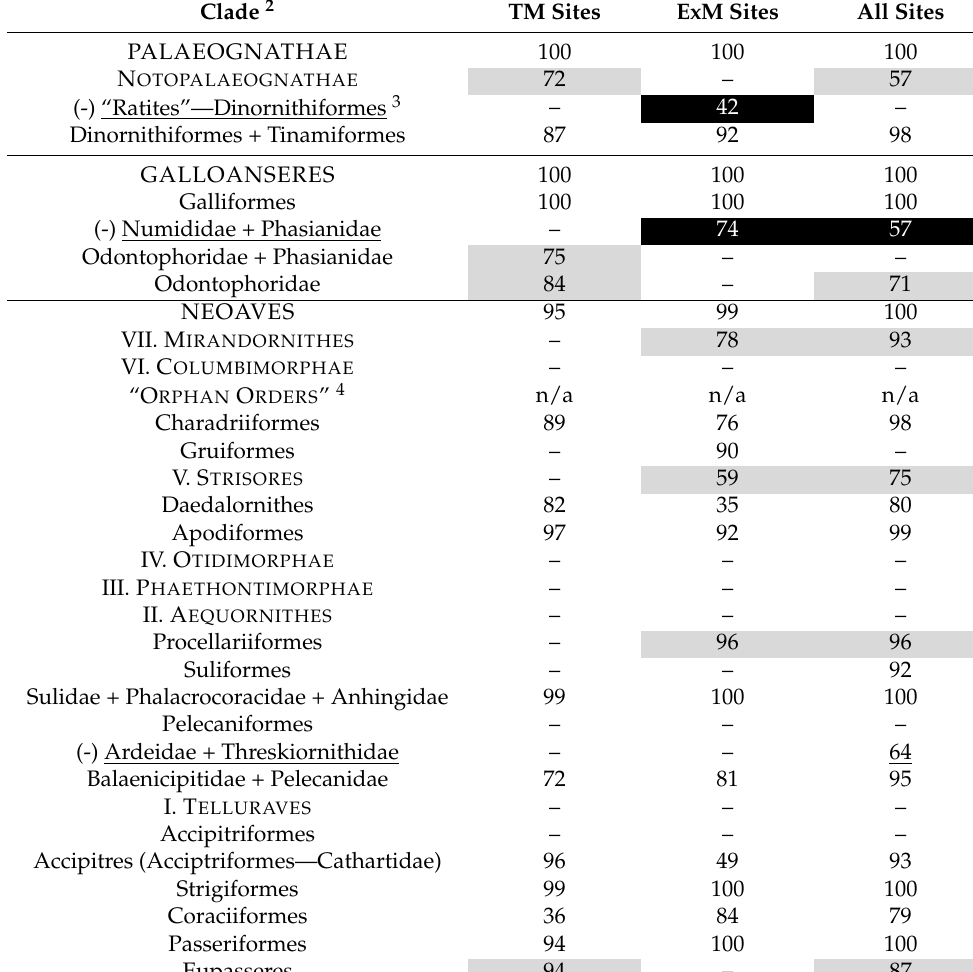
Table 1. Support for selected clades 1 in GTR 20 + I + Γ analyses of TM, ExM, and All (TM+ExM) sites.